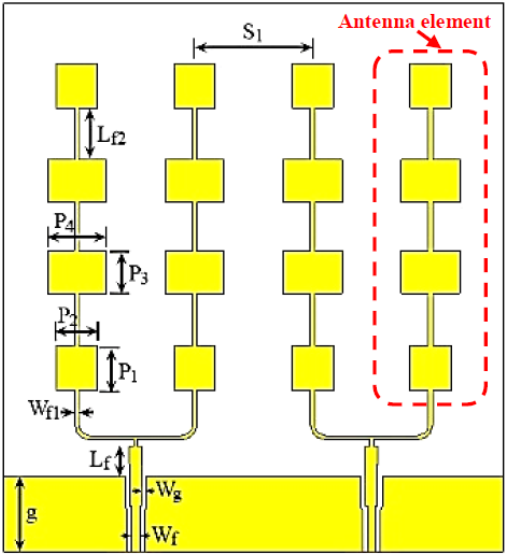
Table 1. The parameters of the proposed transmitter antenna elements.